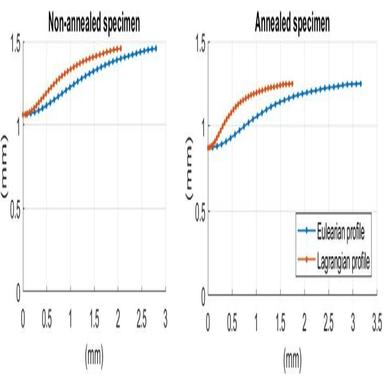
Eulerian and Lagrangian profile at dna for the non-annealed specimen and at da for the annealed one. The ordinate is the radial coordinate r, whereas the abscissa is the axial coordinate x for the Eulerian profiles and X for the Lagrangian profiles.